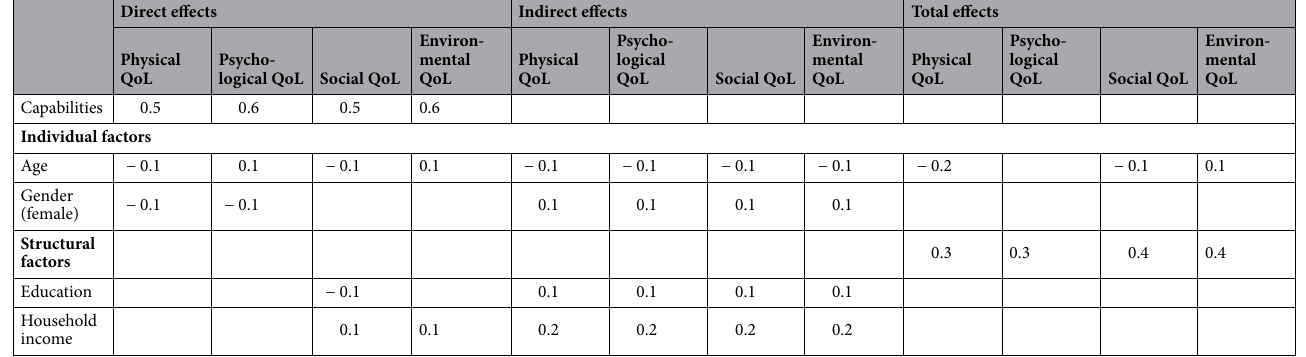
Table 2. The direct, indirect, and total effects of the examined capabilities and individual and structural factors on different QoL dimensions, standardized regression coefficients (B), only statistically significant shown (p < 0.05), PROMEQ data (N = 866).